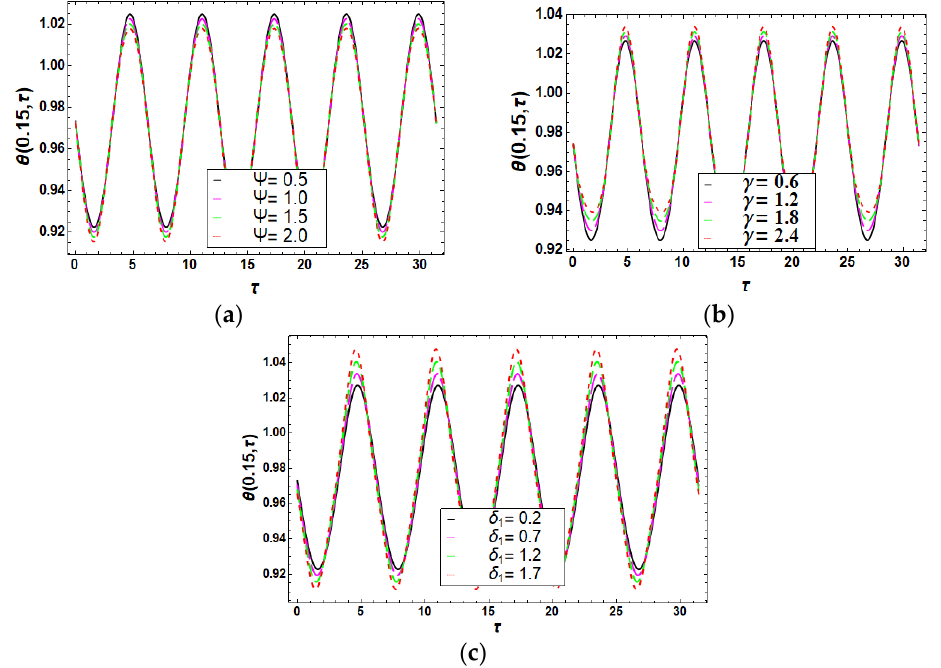
γ θ on . ( c ) E ff ects of 1 on θ